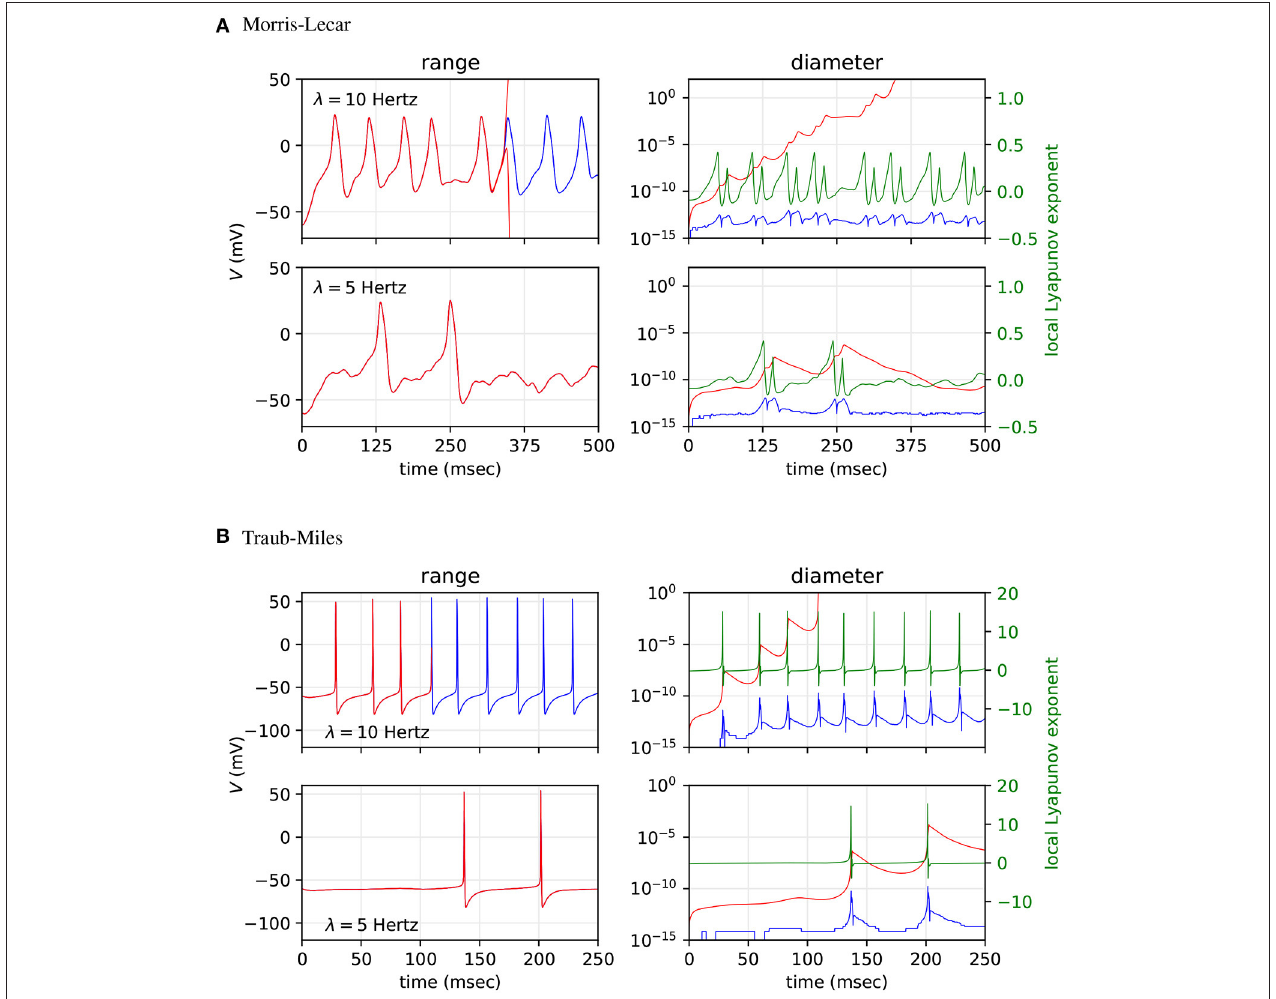
FIGURE 7 | Comparison of mixed trimmed IA/AA ranges (red) and the trajectory boundaries computed from 1,000 floating-point simulations (blue) of a fan-in network with n 500 Poisson input neurons. (A) Results for the Morris-Lecar model. (B) Result for the Hodgkin-Huxley type Traub-Miles model. Top sub-panels show results = with input spike frequency λ 10 Hz and bottom sub-panels with λ 5 Hz. We analysed the range of V (left sub-panels), and the diameter of these ranges (right = = sub-panels). For context, the local Lyapunov exponent is plotted in the right sub-panels